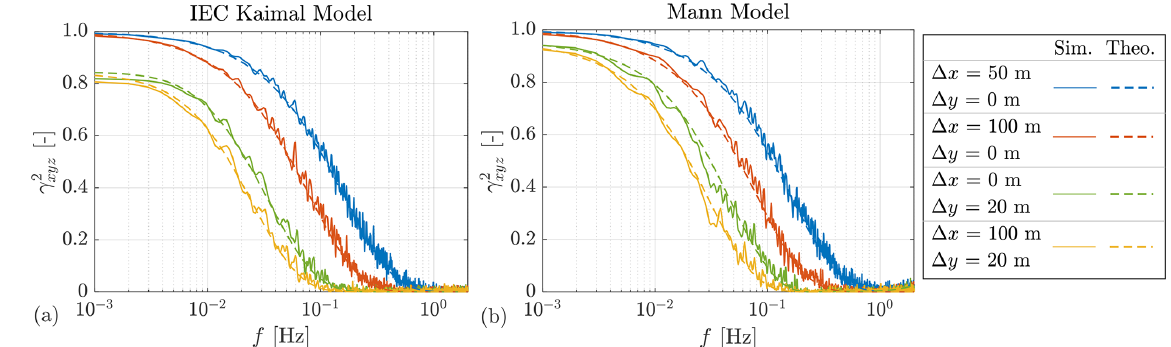
Figure 3. Comparison of the theoretical and simulated coherence between different horizontal separations in 4D wind fields. The simulated coherence is calculated by dividing the averaged cross-spectra by the auto-spectra of 16 samples. Sim.: simulated. Theo.: